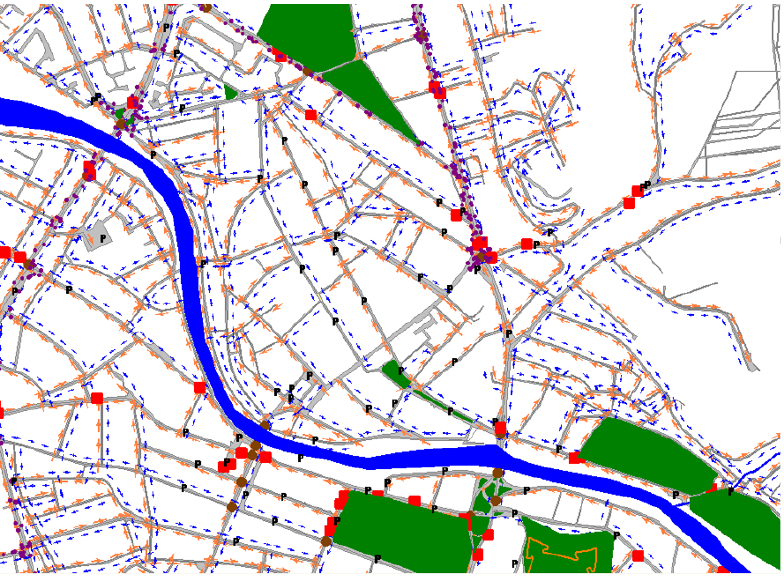
Figure 1. Representation on map of various traffic signs, Oradea (realized by the authors)